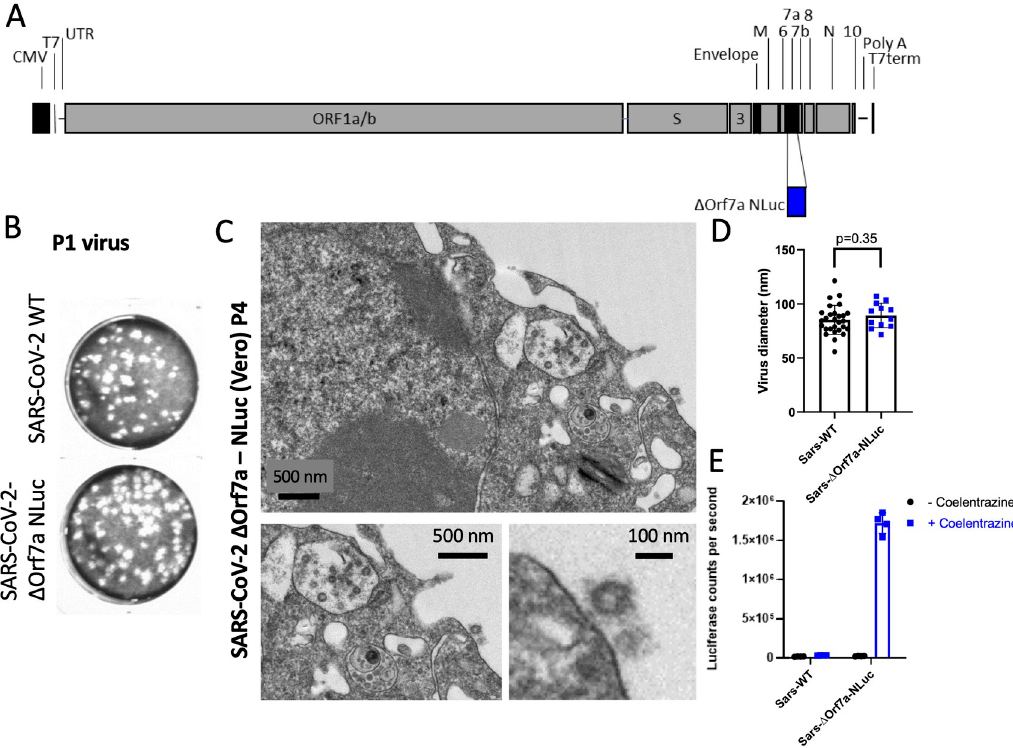
Fig 1. Nanoluciferase (NLuc) modified SARS-CoV-2 virus as a reporter for virus replication. A) Diagram of the SARS-CoV- 2 genome highlighting the insert site for the reporter NLuc in place of Orf7a, (SARS-CoV-2- Δ Orf7a-NLuc). B) Virus particles recovered following transfection of wild-type (WT) or NLuc modified SARS-CoV-2 encoding RNA into 293T cells were used to infect Vero cells. The recovered virus (P1 virus) was then titered in Vero cells to assess virus replication and plaque forming potential. C) Electron microscopy of the SARS-Cov-2 virus 72 h.p.i. of Vero cells (Passage 4, P4), both intra- and extra-cellular virus particles were identified. D) Measurement of diameter for the wild-type (WT) and NLuc modified SARS-CoV-2 particles. E) Measurement of NLuc activity in medium of Vero cells infected wild-type (WT) and NLuc modified SARS-CoV-2 virus without and with addition of the NLuc substrate